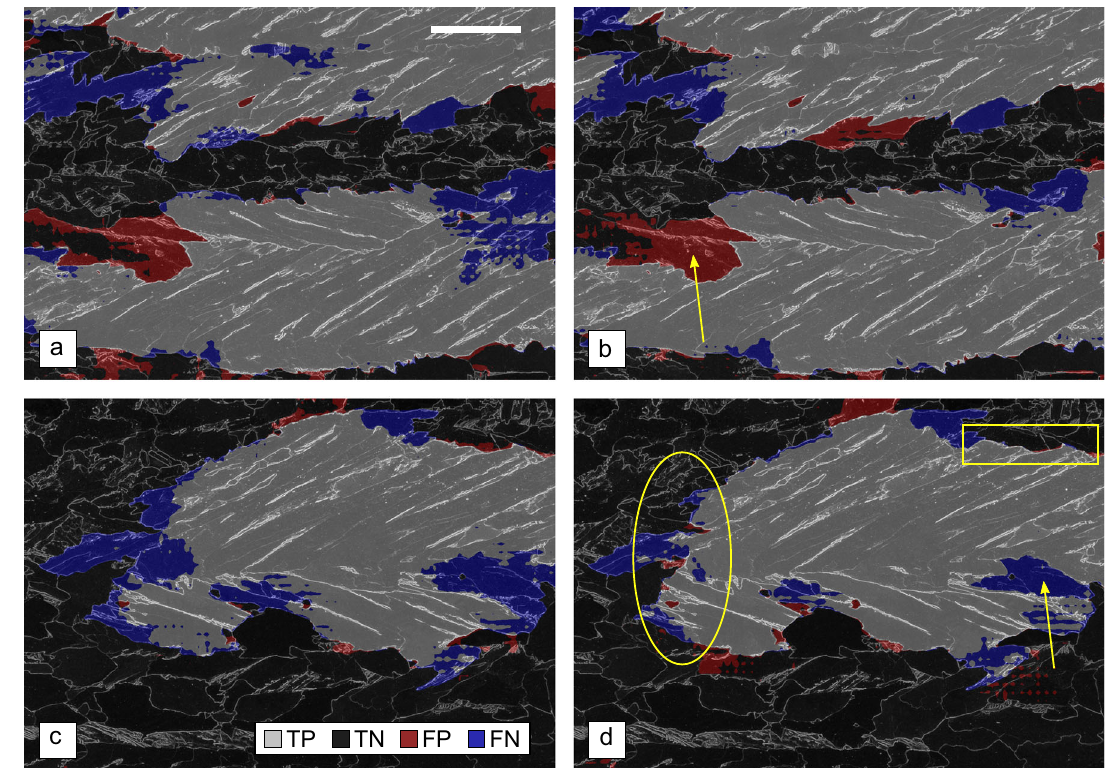
Fig. 2 Predictions on the target 1 test images. The left column ( a ), ( c ) gives the predictions of a DeepLabv2 model trained on the source dataset (cf. experiment T1.10). The right column ( b ), ( d ) give the predictions of a DeepLabv2 model trained with the UDA framework on the source and target 1 datasets (cf. experiment T1.11). Annotations are used for the description of the results in the text. TP, TN, FP, and FN stand for true positives, true negatives, false positives, and false negatives, respectively, the positive class being the lath-bainite foreground. The scale bar width corresponds to 10 μ